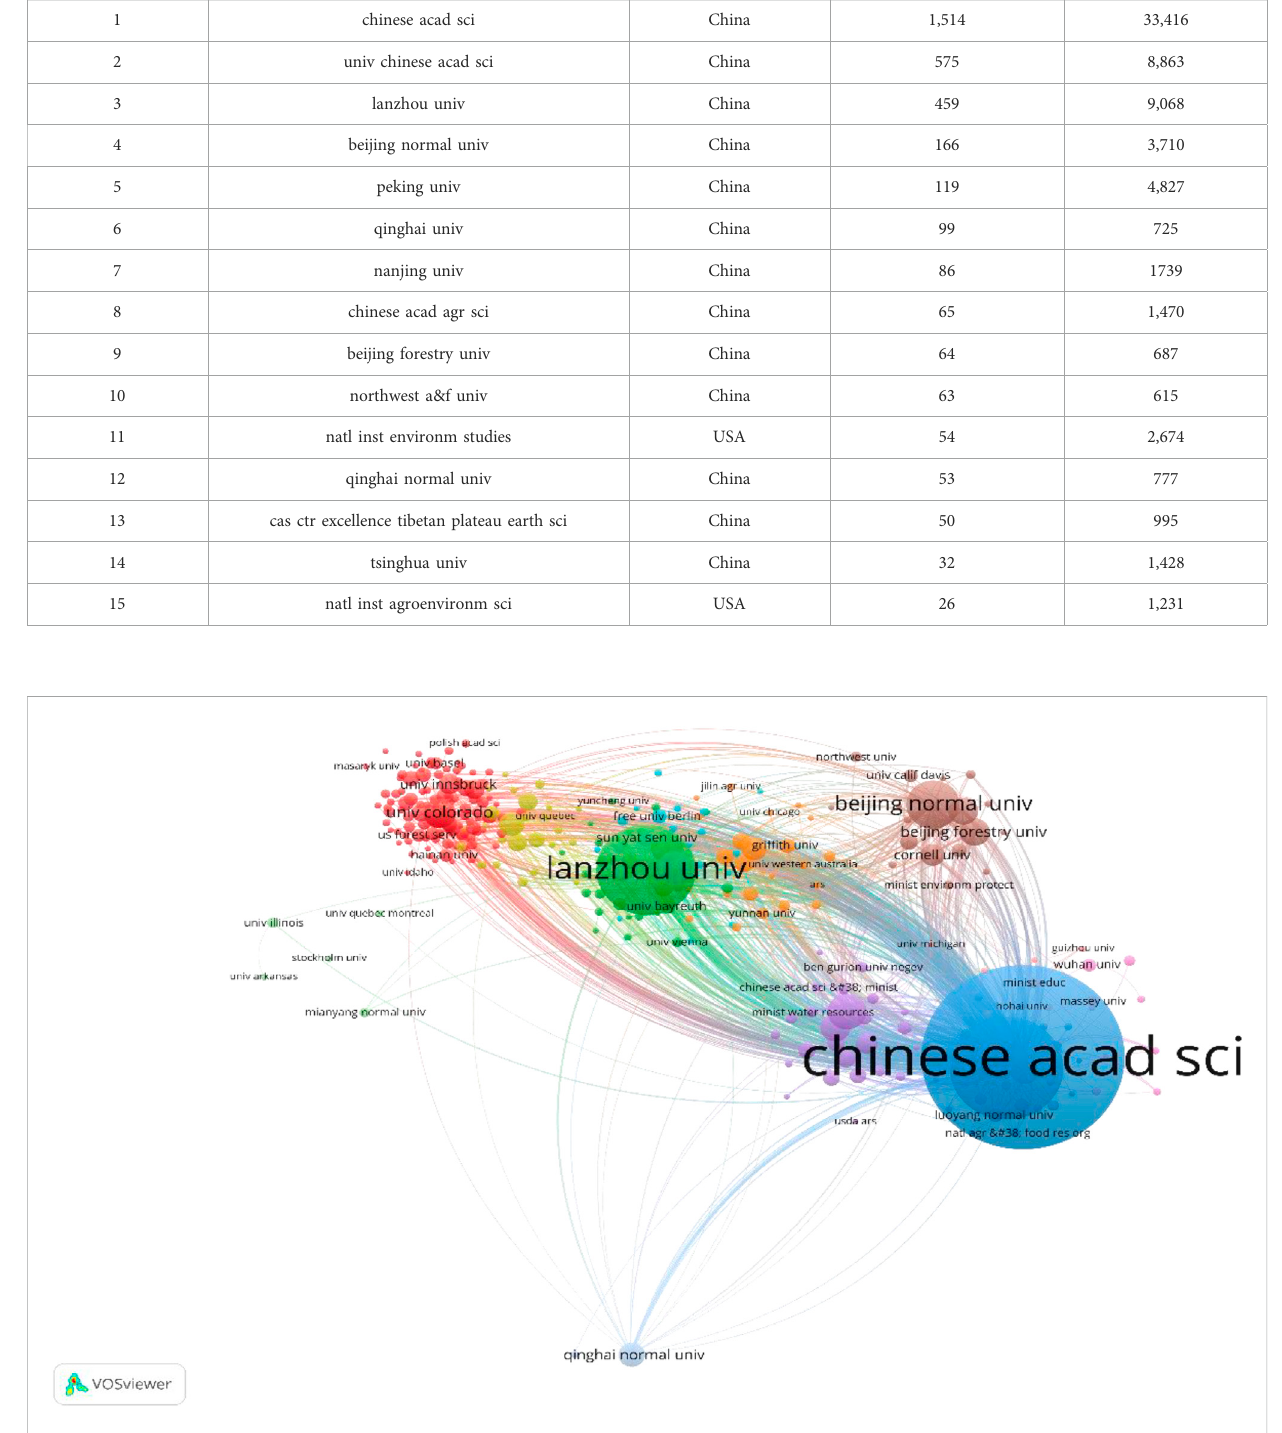
FIGURE 6 Mapping analysis of institutional cooperation network in the fi eld of alpine meadow